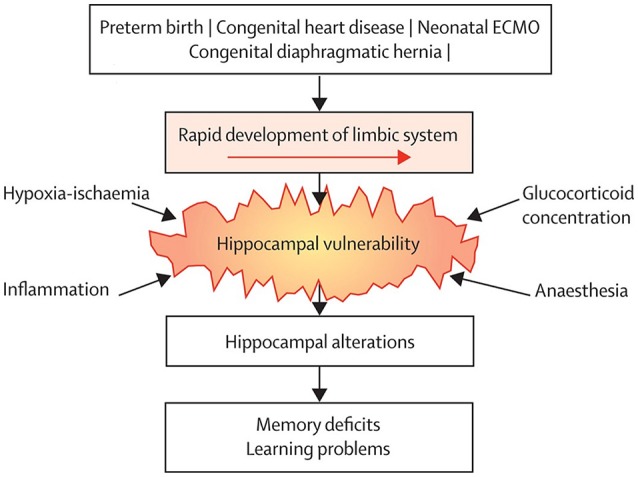
Common neurodevelopmental pathway following neonatal critical illness. Survivors of neonatal critical illness share an increased risk of hippocampal alterations due to vulnerability to common conditions associated with neonatal critical illness, which leads to long-term memory deficits. ECMO = extracorporeal membrane oxygenation. Reprinted from The Lancet Child Adolesc Health Schiller et al. (83). Copyright 2018, with permission from Elsevier.